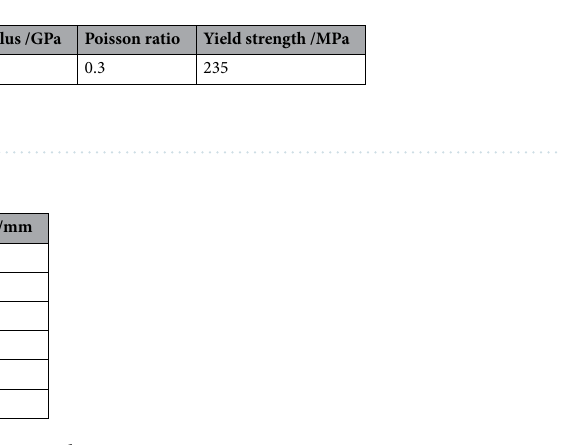
Table 3. Cross-sectional dimensions of